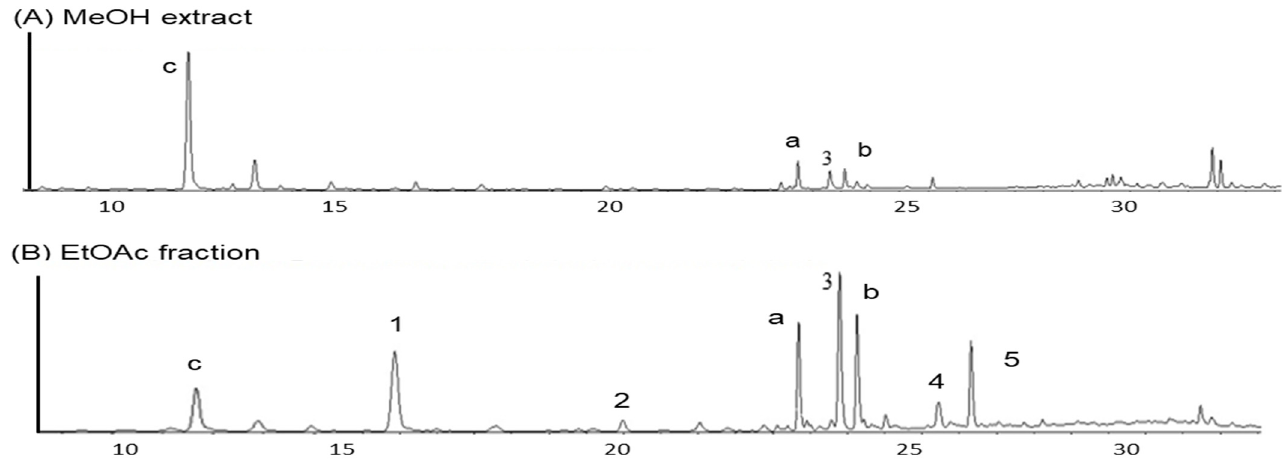
Figure 2. UPLC chromatograms of MeOH extract ( A ) and EtOAc fraction ( B ). Peak 3 (chlorogenic acid); Peak 1 ( p -coumaric acid): 12.83 min; Peak 2 (chlorogenic acid methyl ester): 19.95 min; Peak a (cuercetin 3- O -ß-D-glucoside): 20.55 min; Peak 3 (cxyresveratrol): 22.85 min; Peak b (kaempferol 3- O -ß-D-glucoside): 23.40 min; Peak 4 (macrourin B): 25.18 min; Peak 5 (moracin M): 25.80 min.